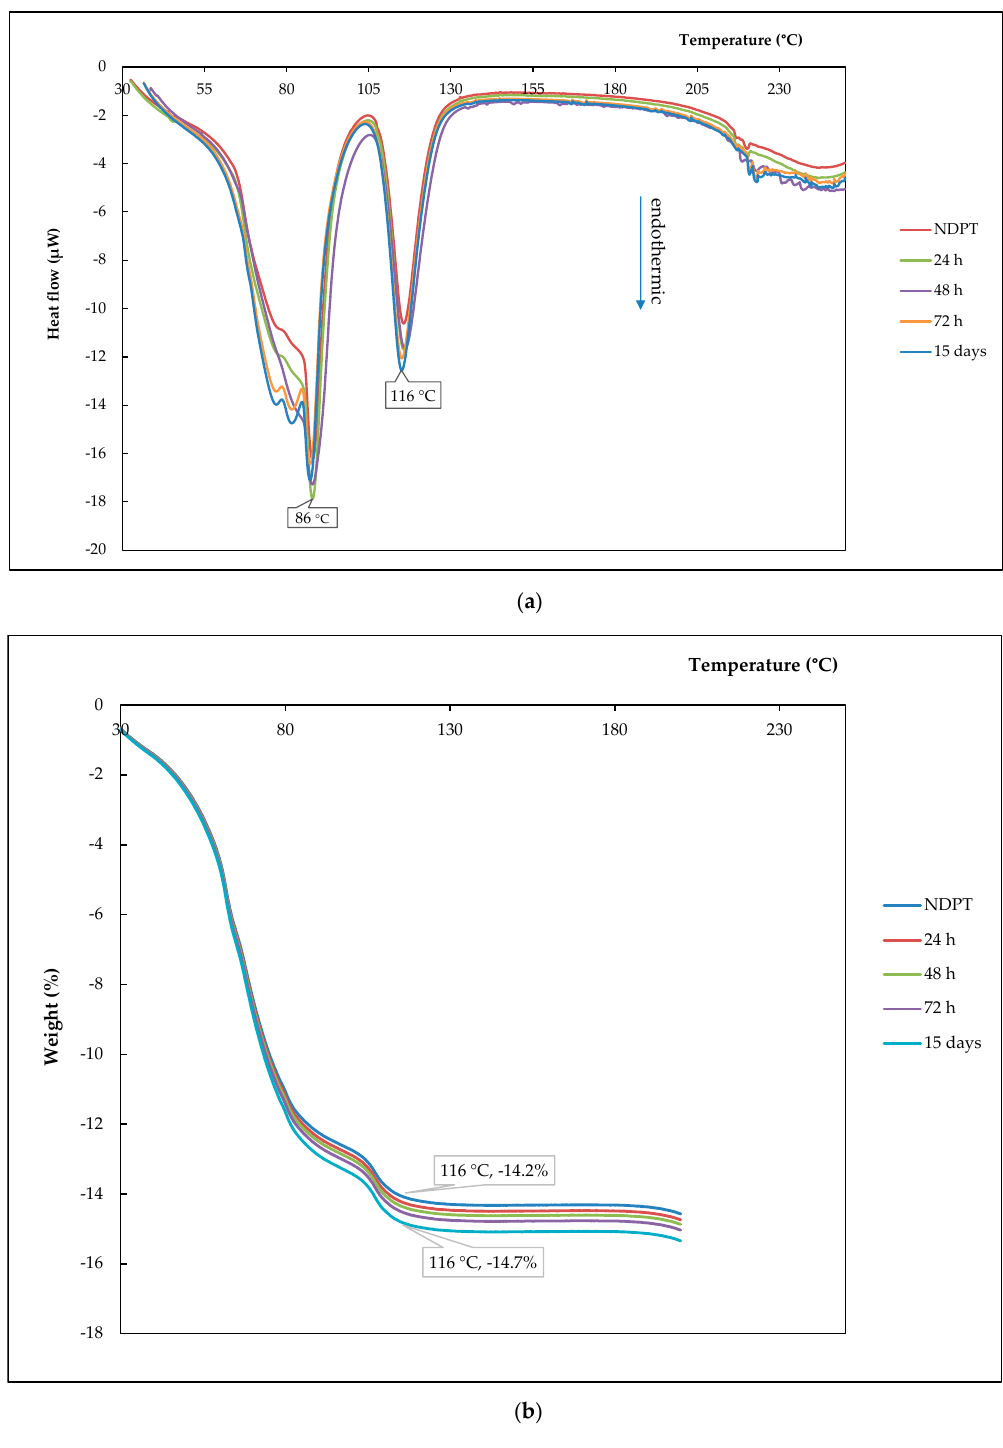
Figure 15. DSC ( a ) and TG ( b ) thermograms of NDPT after storage at high relative humidity of 94% RH/25 ± 2 °C for 24, 48, 72 h, and 15 days.